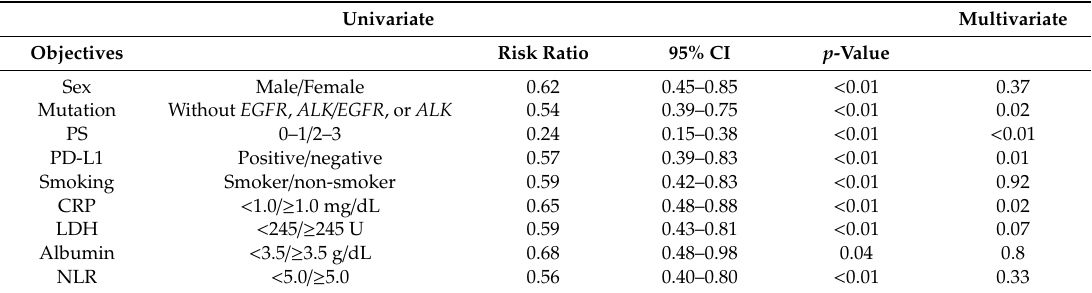
Figure 2. Clinical outcomes in patients treated with ICI. ( A ) Progression-free survival based on each oncogenic subtype and ( B ) overall survival based on each oncogenic subtype.